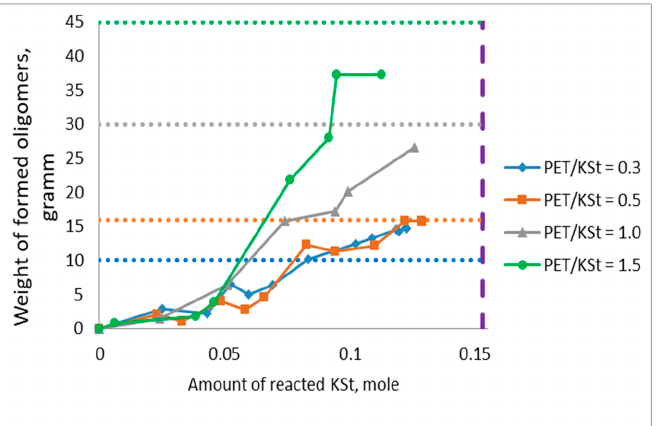
Figure 7. The mass of the precipitate formed at 190 °C with an initial amount of KSt = 0.156 mole correlates with the decreasing amount of determined potassium ions (as potassium stearate equivalents). The vertical line is the total number of potassium ions, the horizontal lines are the total mass of PET for each series of experiments, and the experimental points from left to right corresponded to an increase in reaction time from 10 to 200 min.